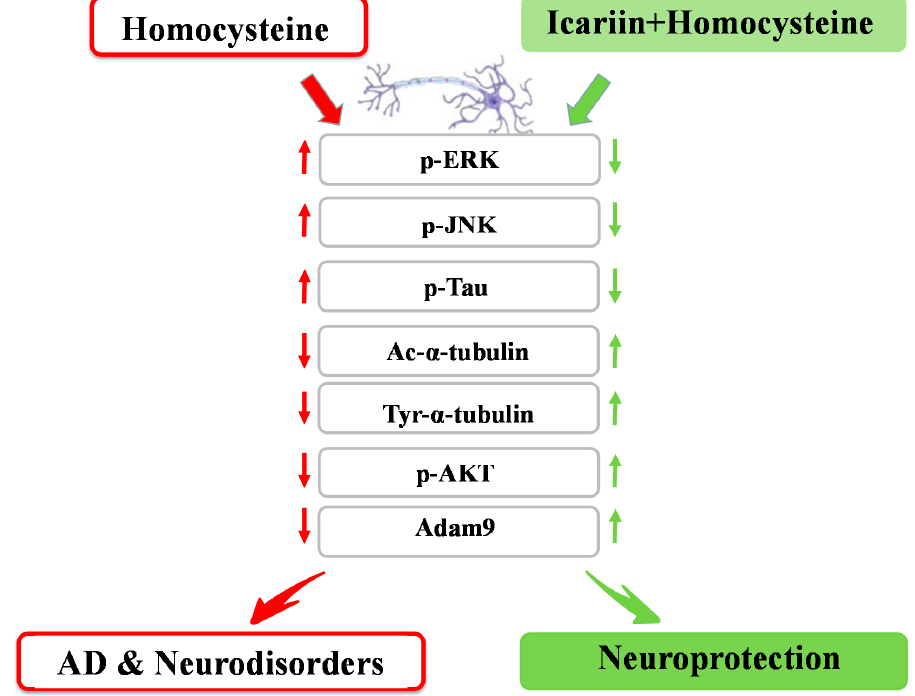
Figure 8. Signaling molecules and factors contributed to the neuroprotective effects of icariin in the primary embryonic cultures of rat cortical neurons. The red arrows indicate the Hcy-induced changes of the protein molecules, while the green arrows indicate the changes of protein molecules altered by the co-treatment of Hcy and icariin. ↑ : upregulation; ↓ : downregulation.